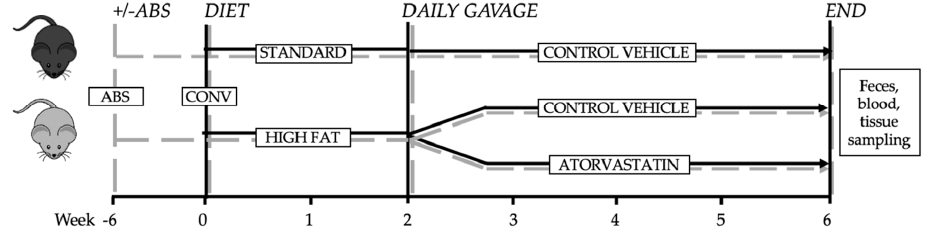
Figure 1. Experimental design. Secondary abiotic mice were generated by quintuple antibiotic treatment ( + ABS). After pretreatment with or without antibiotics both ABS and CONV mice were exposed to either standard chow diet or high-fat diet. Two weeks after initiating the diet ABS and CONV mice were treated, either with control vehicle or atorvastatin for 4 weeks.